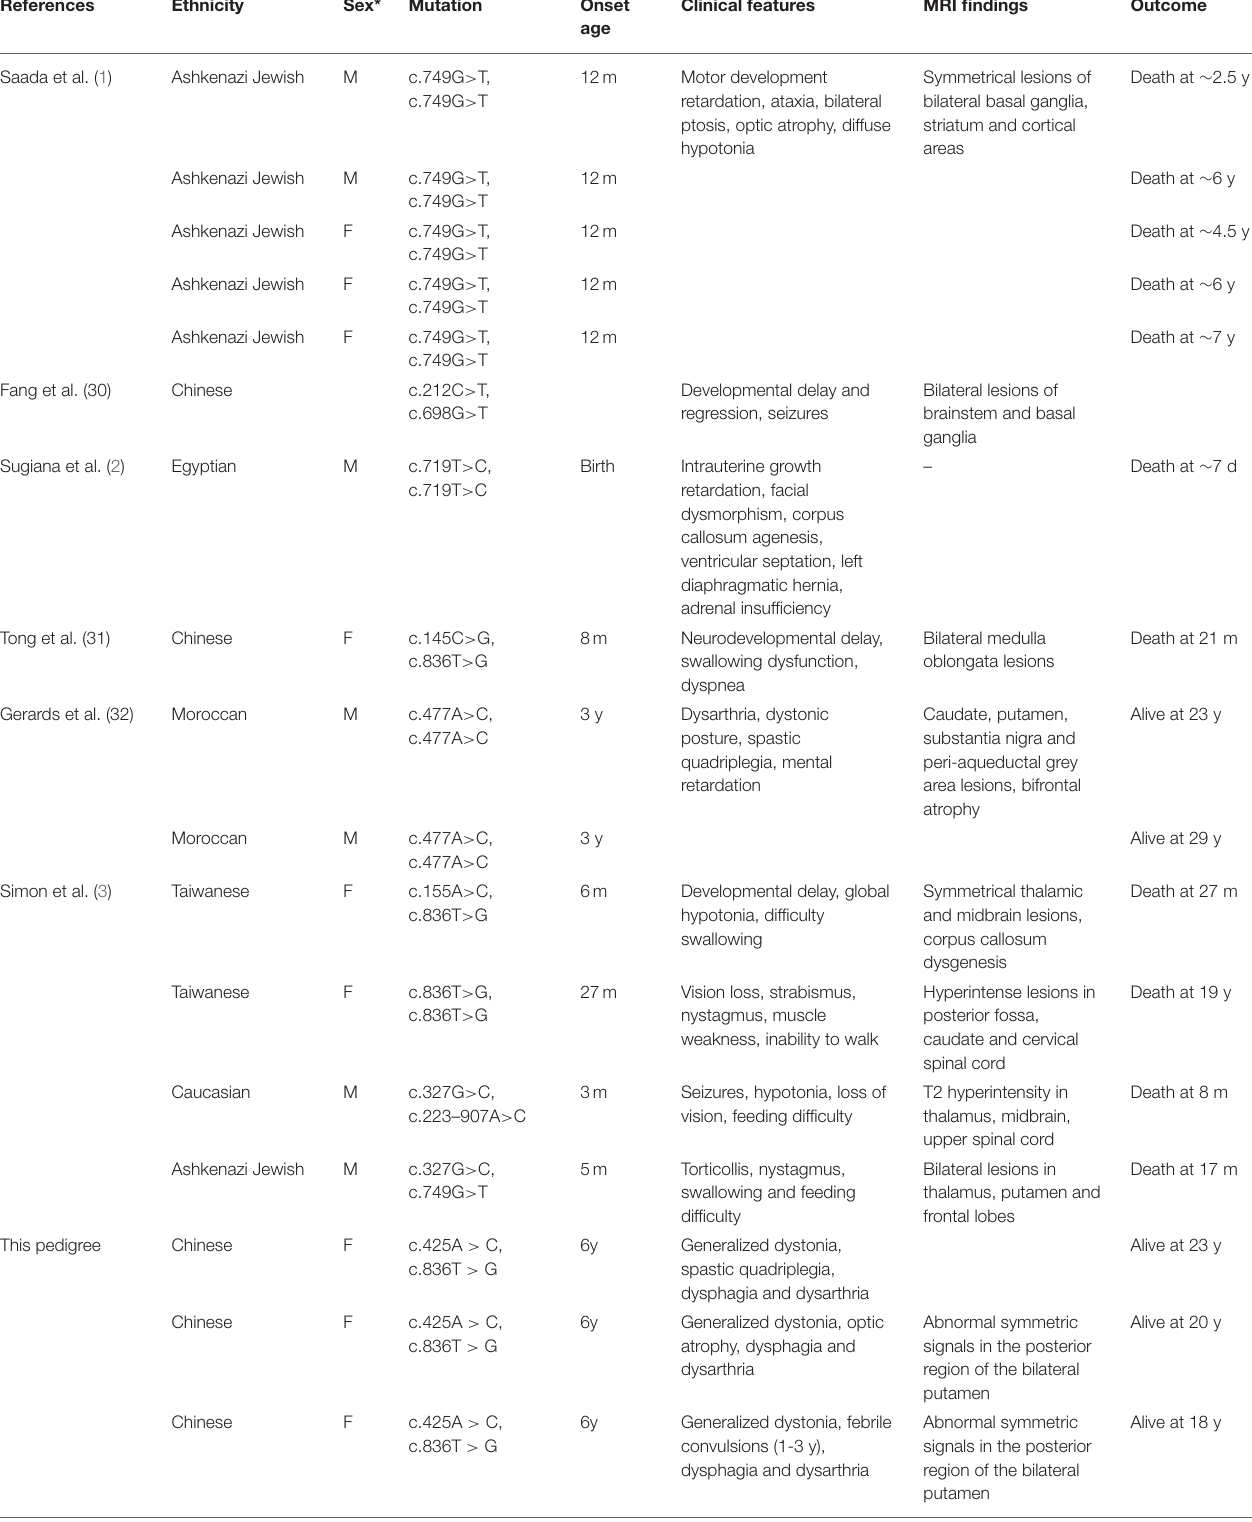
TABLE 1 | Clinical features of patients with NDUFAF5 variations reported in